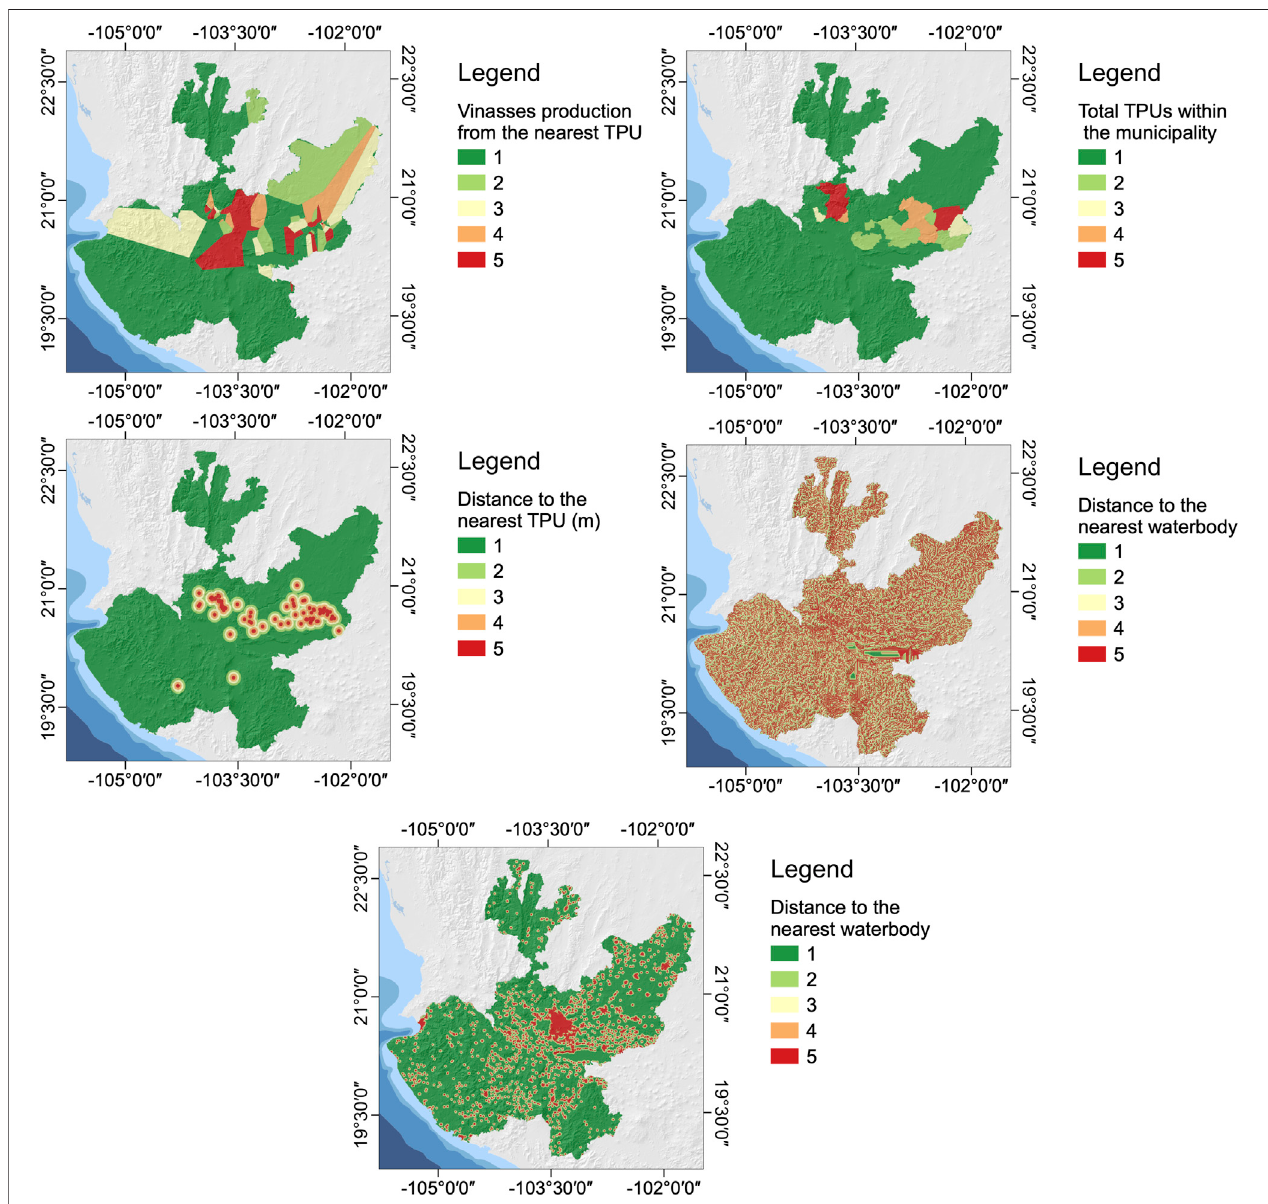
FIGURE 3 | Classi fi cation maps generated for the selected